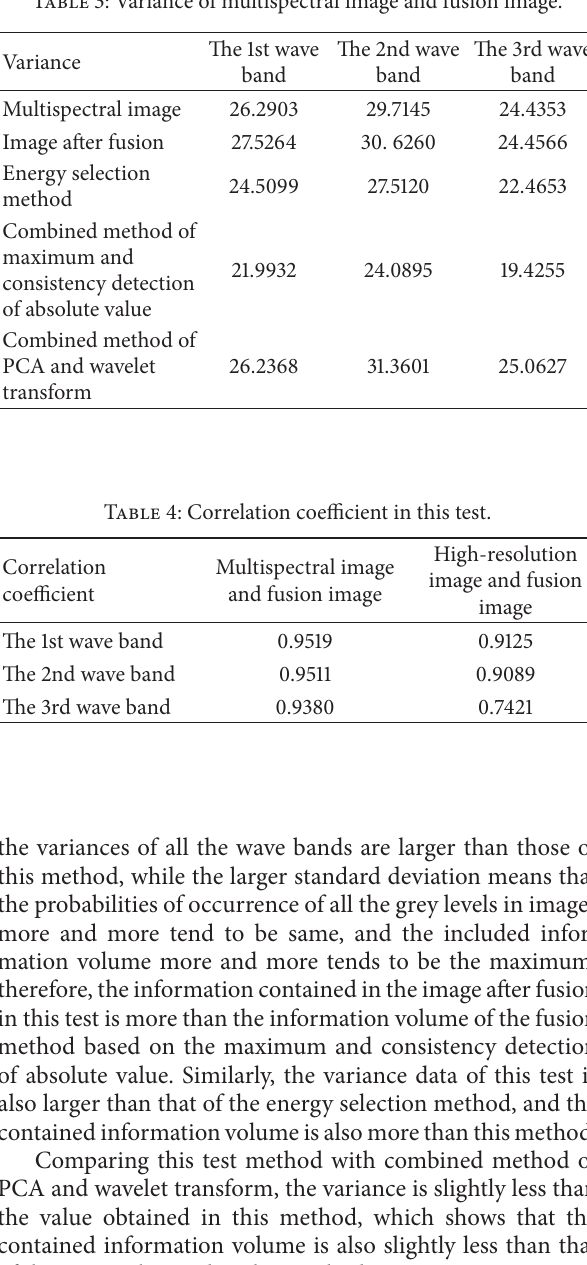
Table 3: Variance of multispectral image and fusion image.